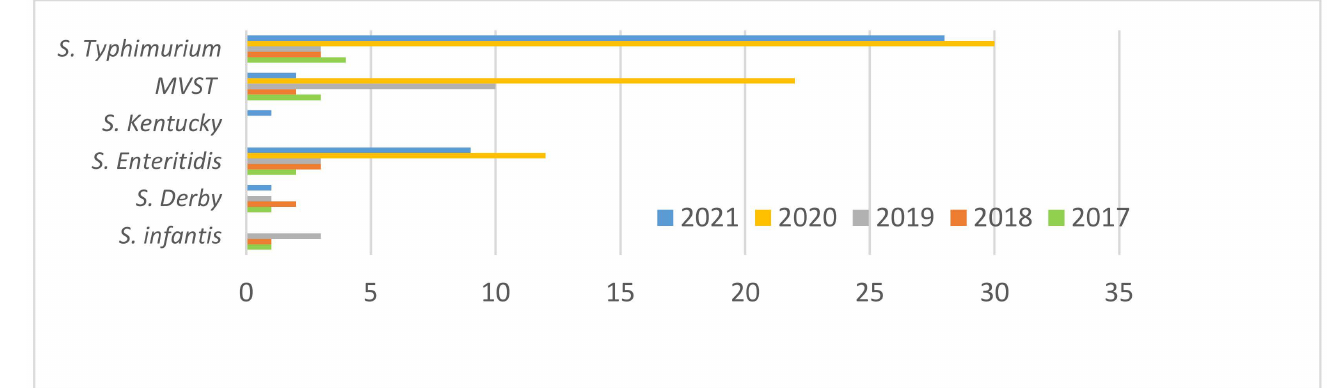
Figure 2. Distribution of S. Infantis, MVST, S. Typhimurium, S. Kentucky, S. Derby and S . Enteritidis per year. H